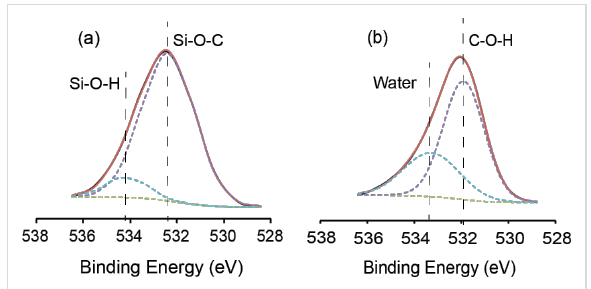
Figure 4: High-resolution XPS O 1s spectra of surfaces (a) thermally functionalized with ethynylbenzyl alcohol and (b) functionalized with ethynylbenzyl alcohol through UV